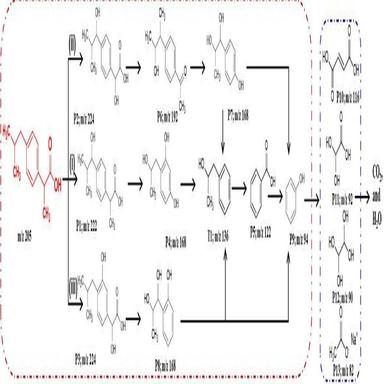
Possible degradation pathways of IBP in the aqueous phase using ACBM/PMS system.